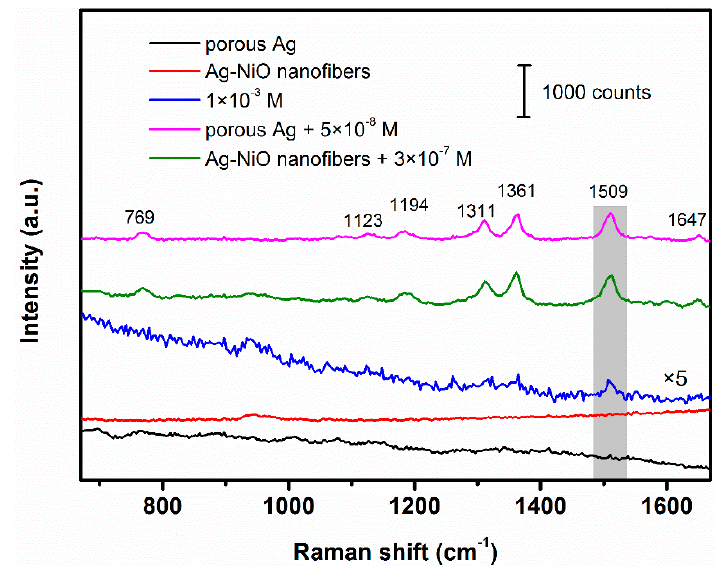
Figure 6. Raman spectra of porous Ag, Ag-NiO nanofibers and R6G at 1 × 10 − 3 M and SERS spectra of R6G at 5 × 10 − 8 M and 3 × 10 − 7 M recorded on porous Ag and Ag-NiO nanofibers, respectively. Table 1. Raman scattering peaks assignment for R6G, melamine and methyl parathion Chemicals Raman Shift (cm − 1 )